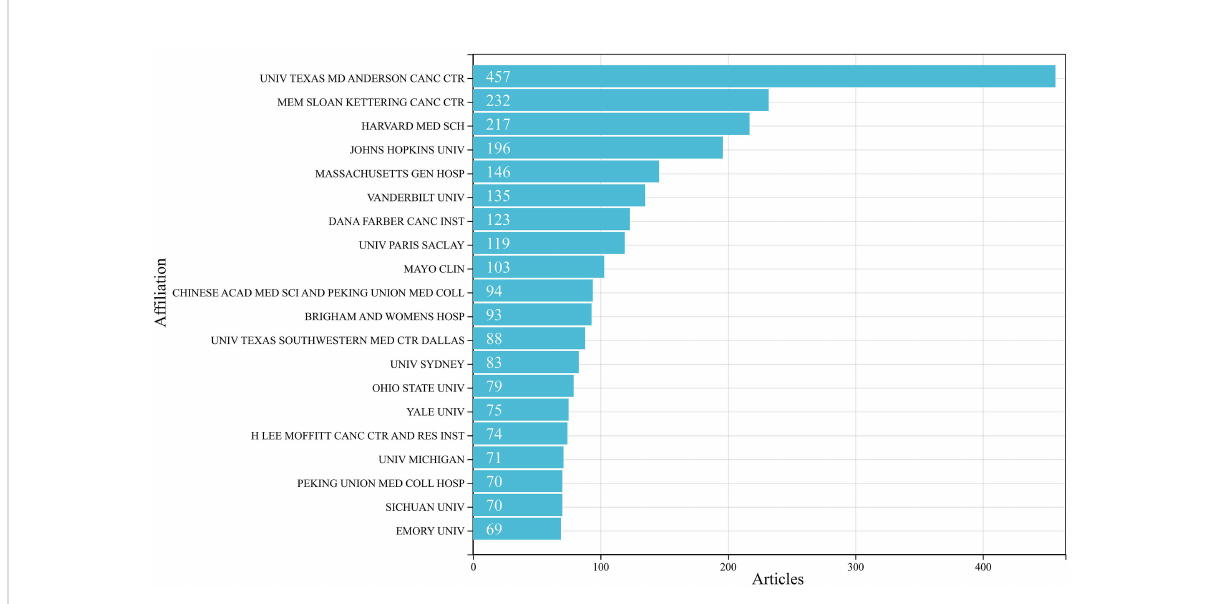
FIGURE 4 The top 20 institutions with the most publications in the fi eld of